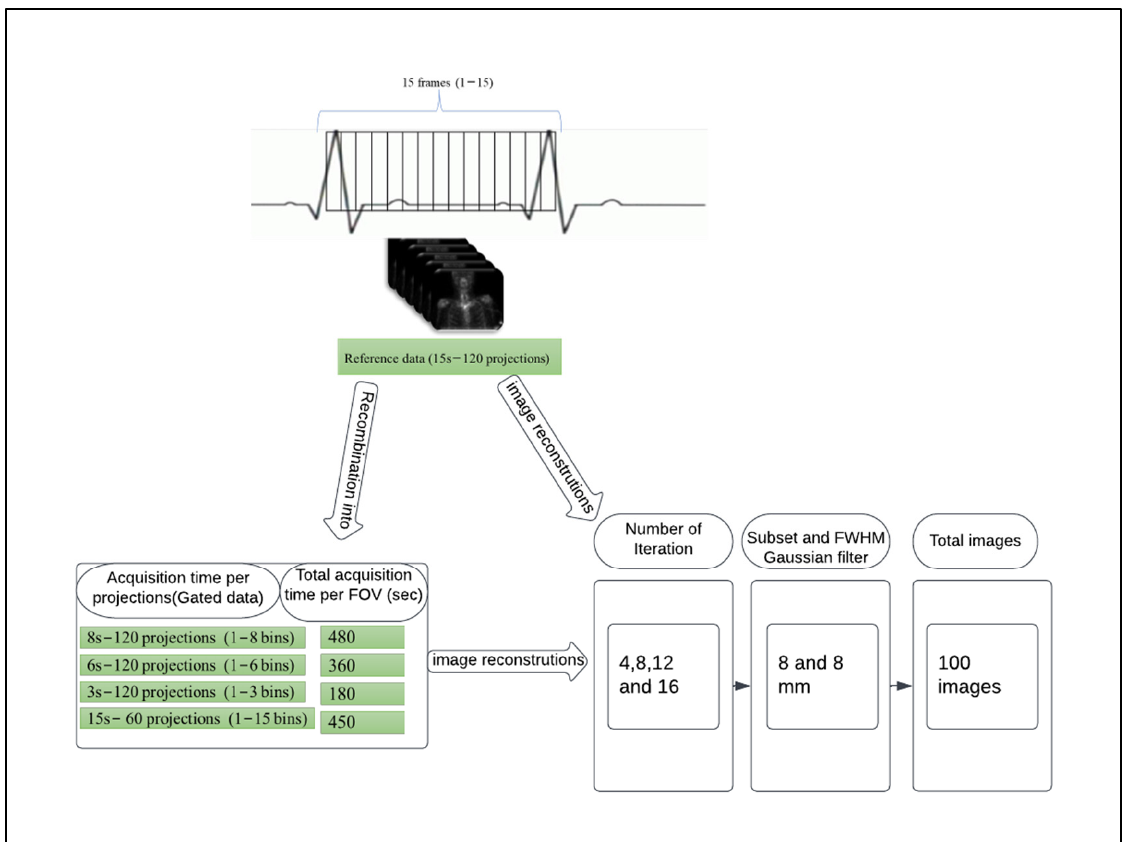
Figure 1. Process for partitioning and recombining bins into lower acquisition time and the image reconstructions utilised at each acquisition period.